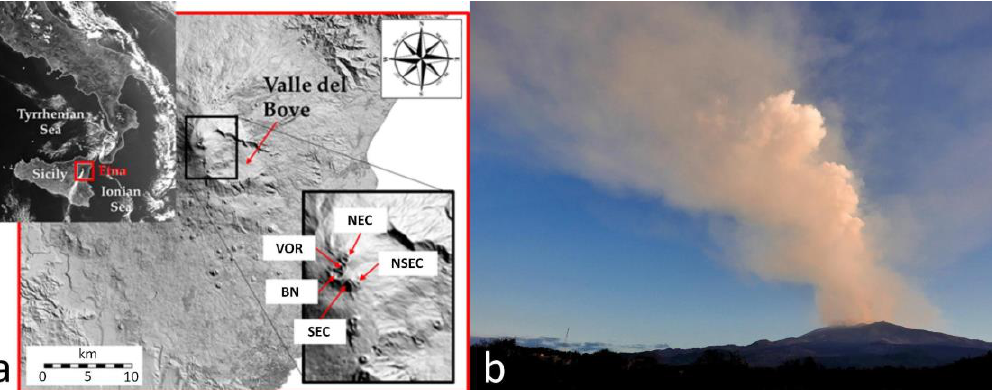
Figure 1. ( a ) Southern Italy image (from MODIS-Aqua data collected the 27 December 2018 at 12:20 UTC) and detail on Etna volcano summit craters (DEM from INGV Dataset “Tinitaly” https://tinitaly.pi.ingv.it/, accessed on 15 May 2019): Voragine (VOR), Bocca Nuova (BN), Northeast Crater (NEC), Southeast Crater (SEC), New SEC (NSEC) (figure modified from Corradini et al.